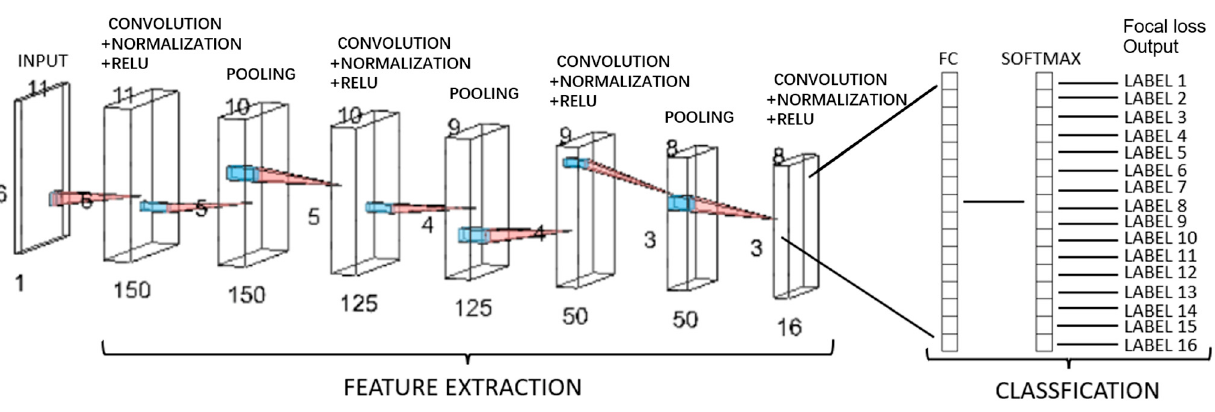
Figure 5. The CNN architecture illustration. Table 2. The 16 class distributions of the sampled cases. (Each case had 625 distribution possibilities).